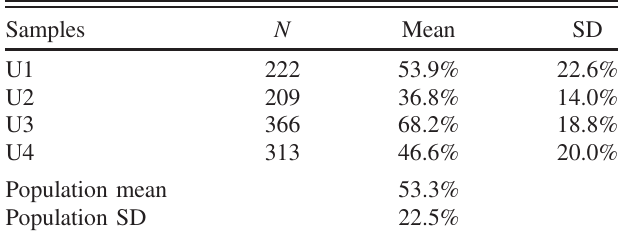
TABLE III. Summary of basic statistics from each university ( 2015 þ 2017 data). “ N ” is the number of respondents and “ SD ” is the standard deviation.